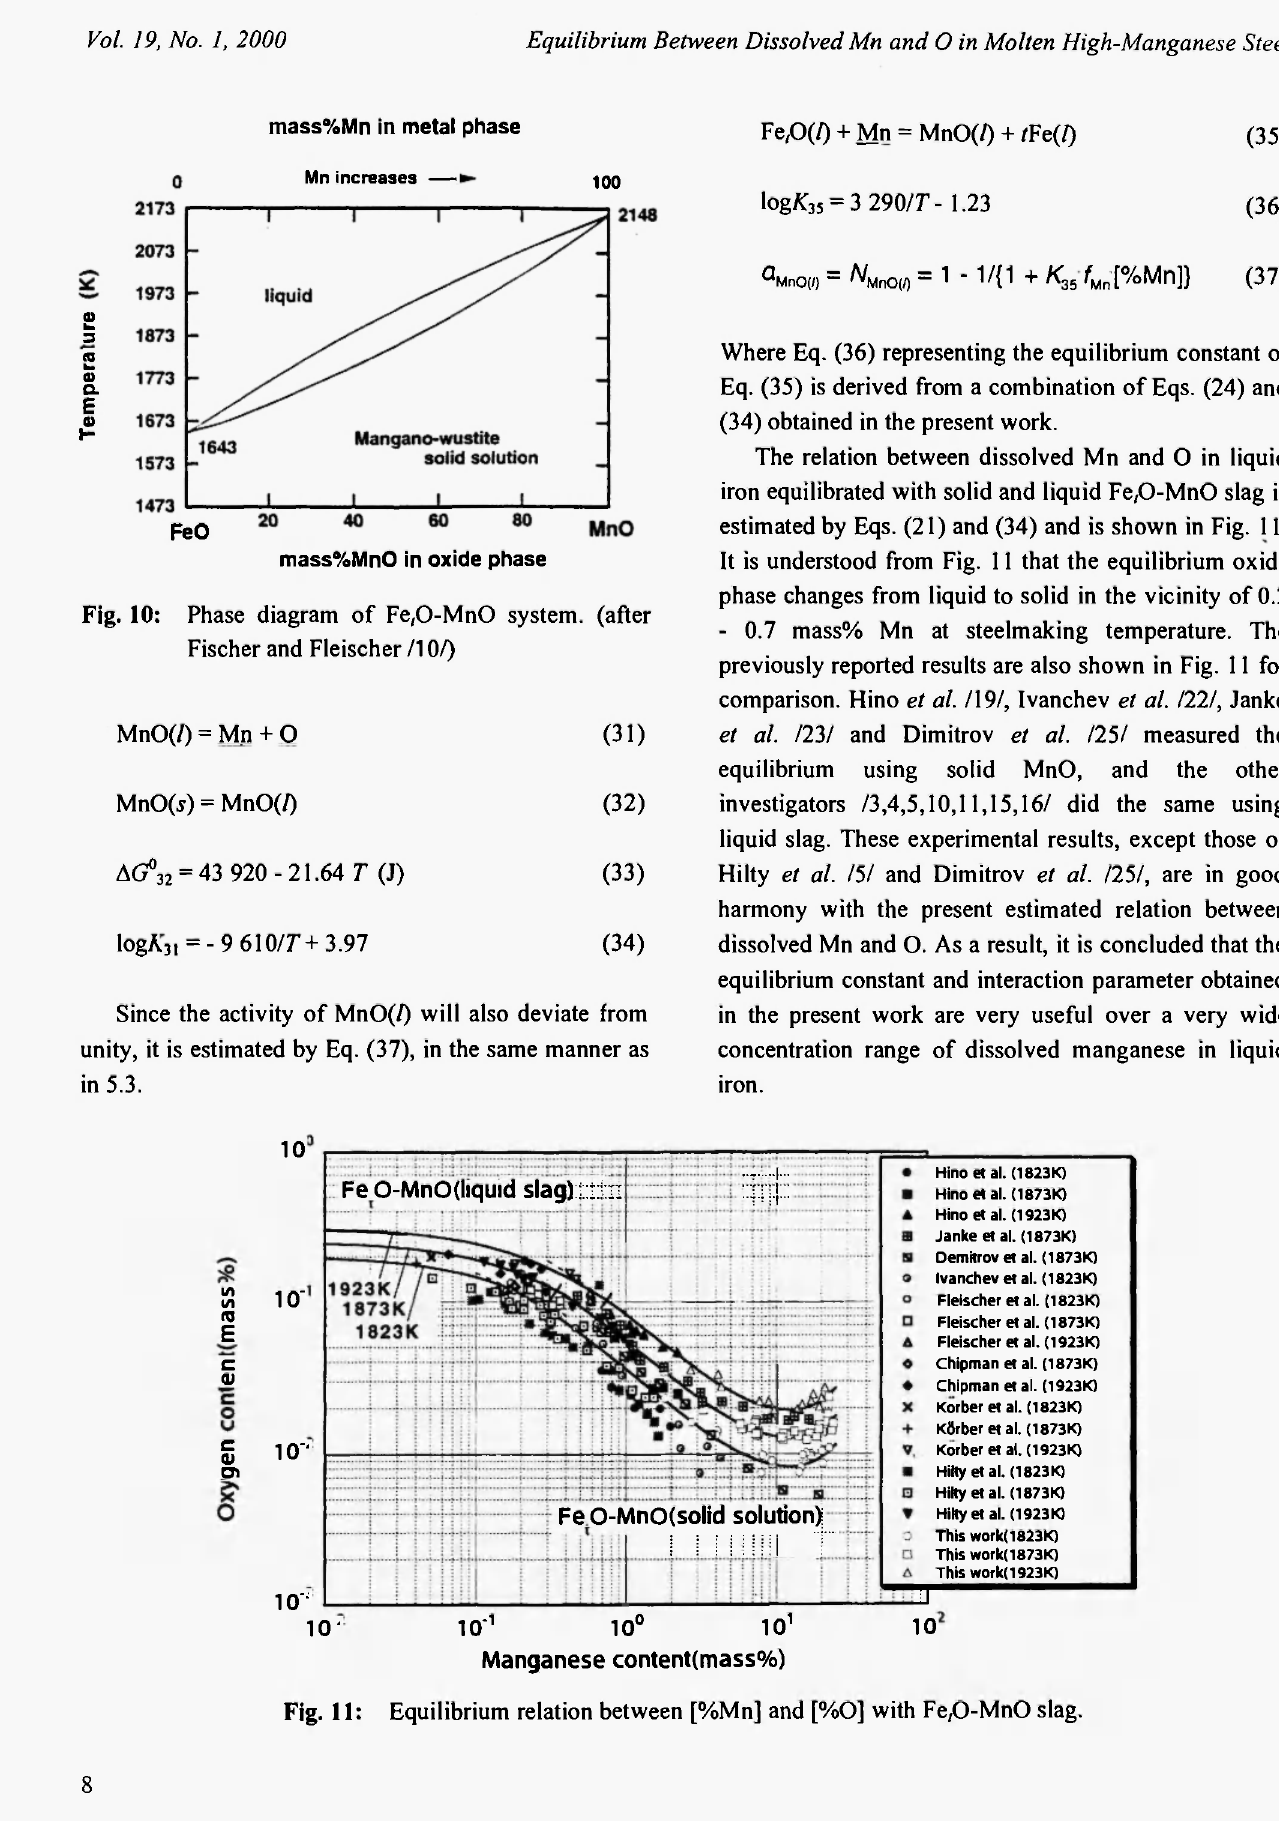
Fig. 11: Equilibrium relation between [%Mn] and [%0] with Fe f O-MnO